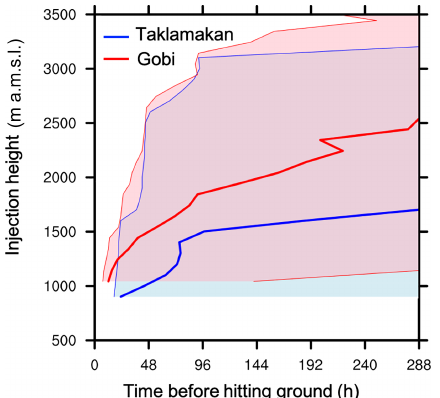
Figure 2. Atmospheric suspension time (hours) of dust parti- cles emitted from the Taklamakan (40 ◦ N, 89 ◦ E; elevation of 805ma.m.s.l.) (blue) and Gobi deserts (43.5 ◦ N, 130 ◦ E; elevation of 954ma.m.s.l.) (red) as a function of injection height (ma.m.s.l.), based on trajectories in March–May of 2001–2003. The thick lines (shading) represent the median (10th to 90th percentiles) of suspen- sion time among 276 trajectories for each injection